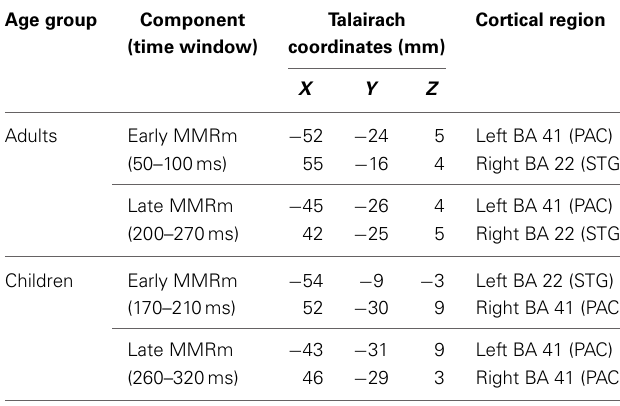
Table 3 | Mismatch response—center of mass activity for sLORETA